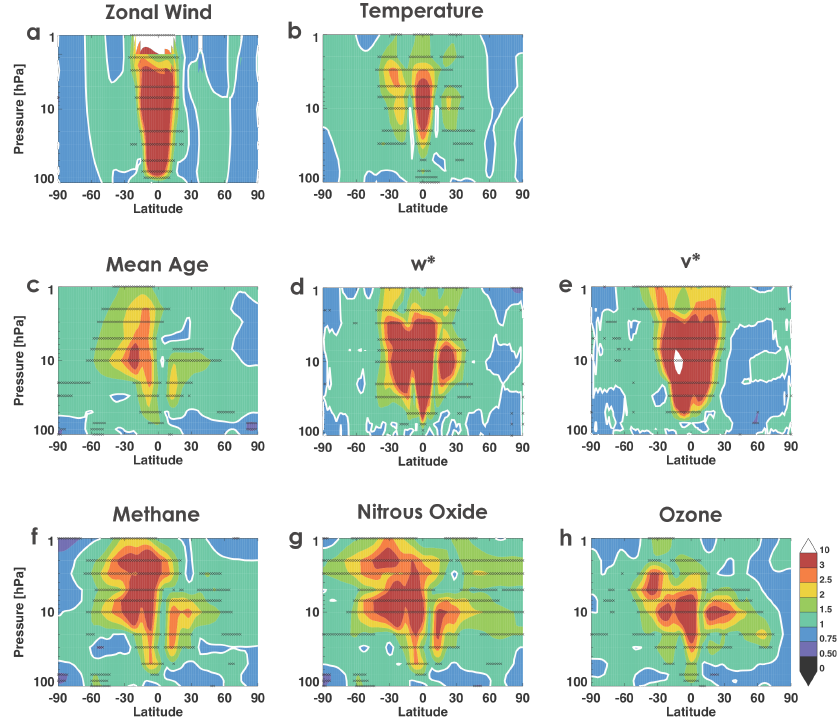
Figure 4 : Q / N changes in variance. White contours indicate where the variance ratio 520 Fig. 4. Q/N changes in variance. White contours indicate where the variance ratio is equal to one. Black Xs indicate changes significant at is equal to one. Black Xs indicate changes significant at the 95% level in an f–test. 521 the 95% level in an f